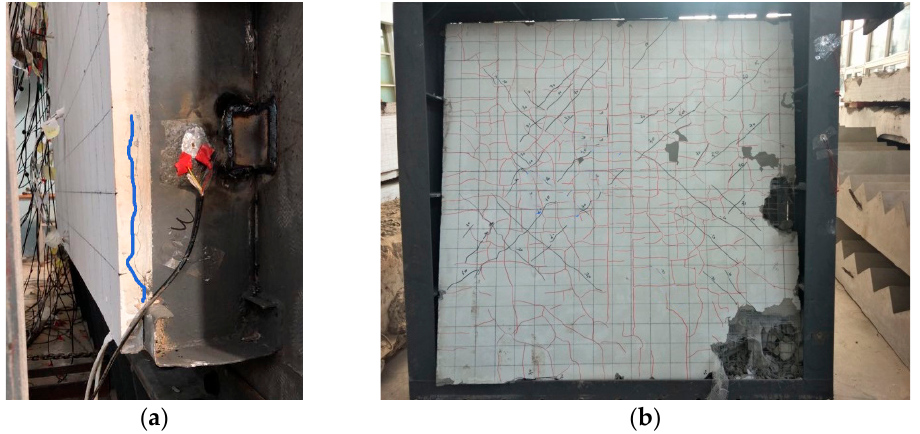
Figure 9. Damage to the WP-2 specimen: ( a ) vertical cracks; ( b ) the failure mode after